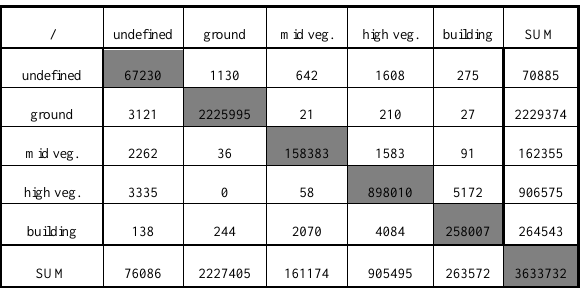
Table 2. Confusion matrix of the automatic